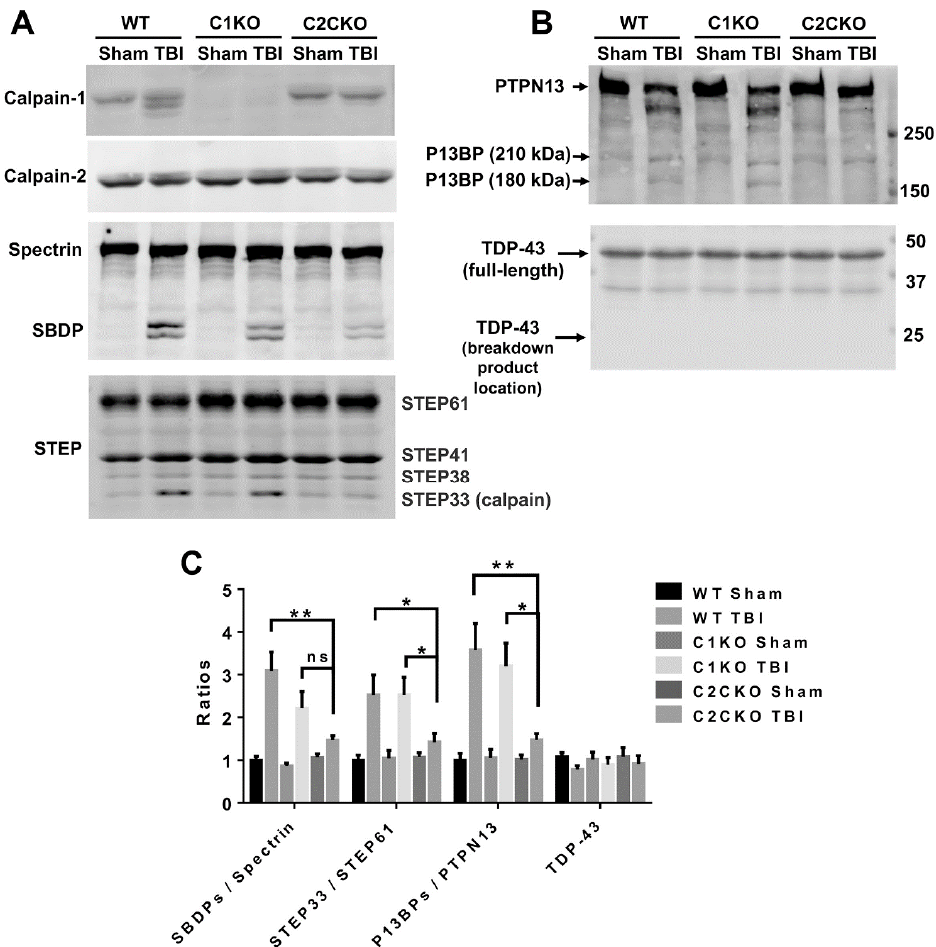
Figure 2. Changes in spectrin, striatal-enriched tyrosine phosphatase (STEP), PTPN13 breakdown product (P13BP), and TAR DNA-binding protein of about 43 kDa (TDP-43) in brain of WT, calpain-1 knock out (C1KO), and C2CKO mice 24 h after traumatic brain injury (TBI). ( A , B ) Representative western blots (WBs) of ipsilateral cortical tissue (P2 fraction) from WT, C1KO, and C2CKO mice collected 24 h after TBI or sham surgery. Note that calpain-1 is absent in C1KO mice and calpain-2 levels were reduced in C2CKO mice. Several calpain substrates including spectrin (1:500; MAB1622, EMD Millipore, Burlington, MA, USA), STEP (1:1000, NB300-202, Novus Biologicals, Littleton, CO, USA), PTPN13 (1:1000, PA5-72906, Thermo Fisher Scientific, Waltham, MA, USA), and TDP-43 (1:1000, 10782-2-AP, Proteintech, Chicago, IL, USA) were probed, and their fragments generated by calpain cleavage including SBDP, STEP33, and P13BPs were detected after TBI. ( C ) Quantification of WB. Ratios of SBDPs to spectrin, STEP33 to STEP61, P13BPs to PTPN13 were significantly increased in WT and C1KO but not in C2CKO mice after TBI. Levels of TDP-43 were not changed after TBI in all genotypes. * p < 0.05, ** p < 0.01. ns, no significant difference. N = 4. One way ANOVA followed by Bonferroni’s test. Full immunoblots for the blots shown here are presented in the Supplementary Materials.